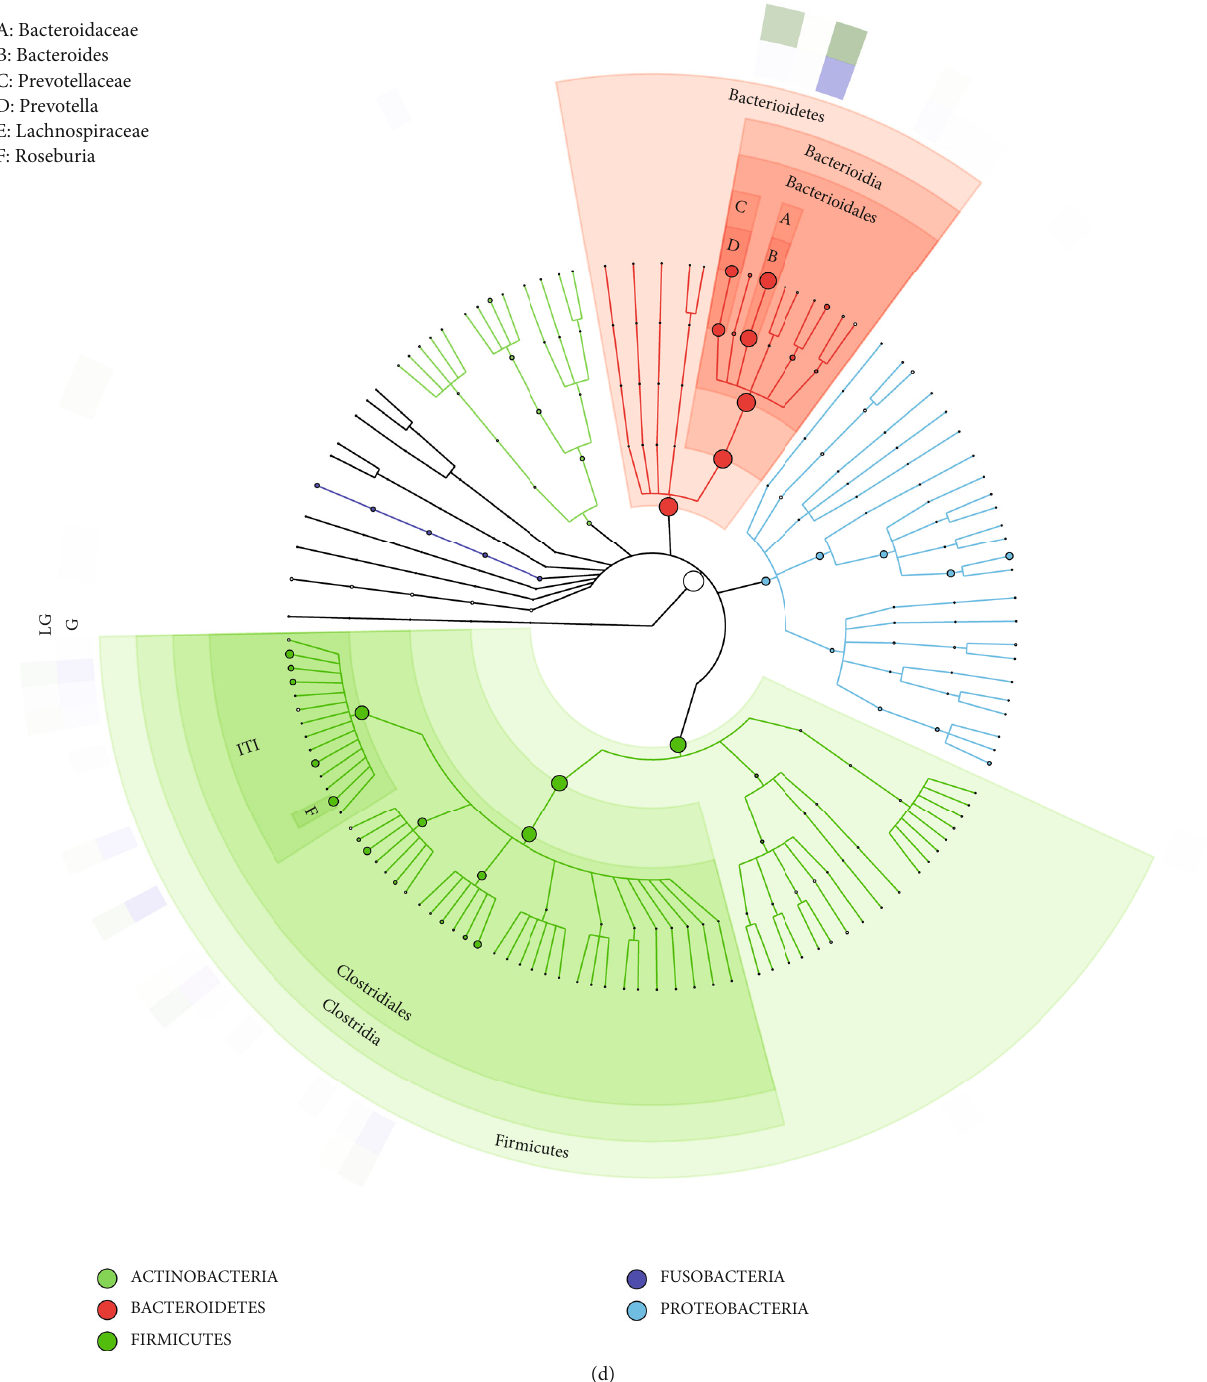
Figure 3: OTU species composition analysis. (a, c) NOR group, GDM group, G group, and LG group heat map cluster analysis. (b, d) NOR group, GDM group, G group, and LG group GraPhlan species composition